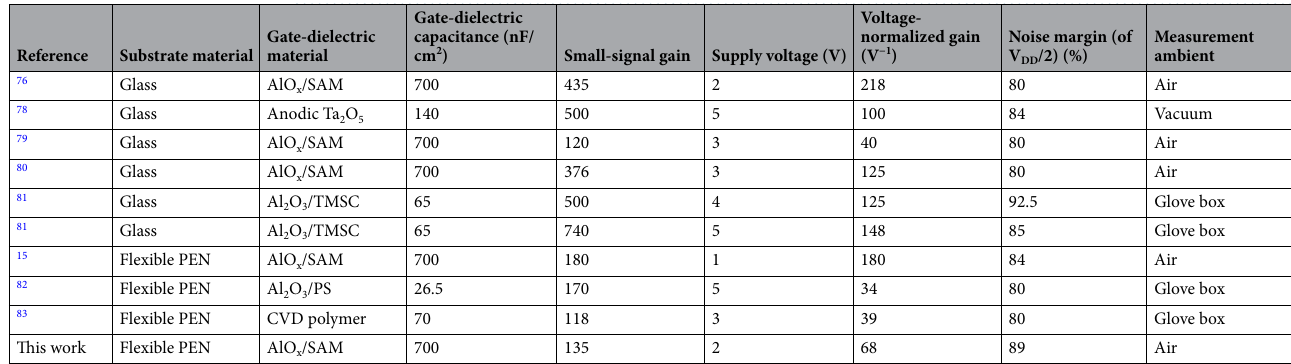
Table 1. Summary of organic complementary inverters with a small-signal gain greater than 100 and a minimum noise margin of at least 80% of half the supply voltage (V DD